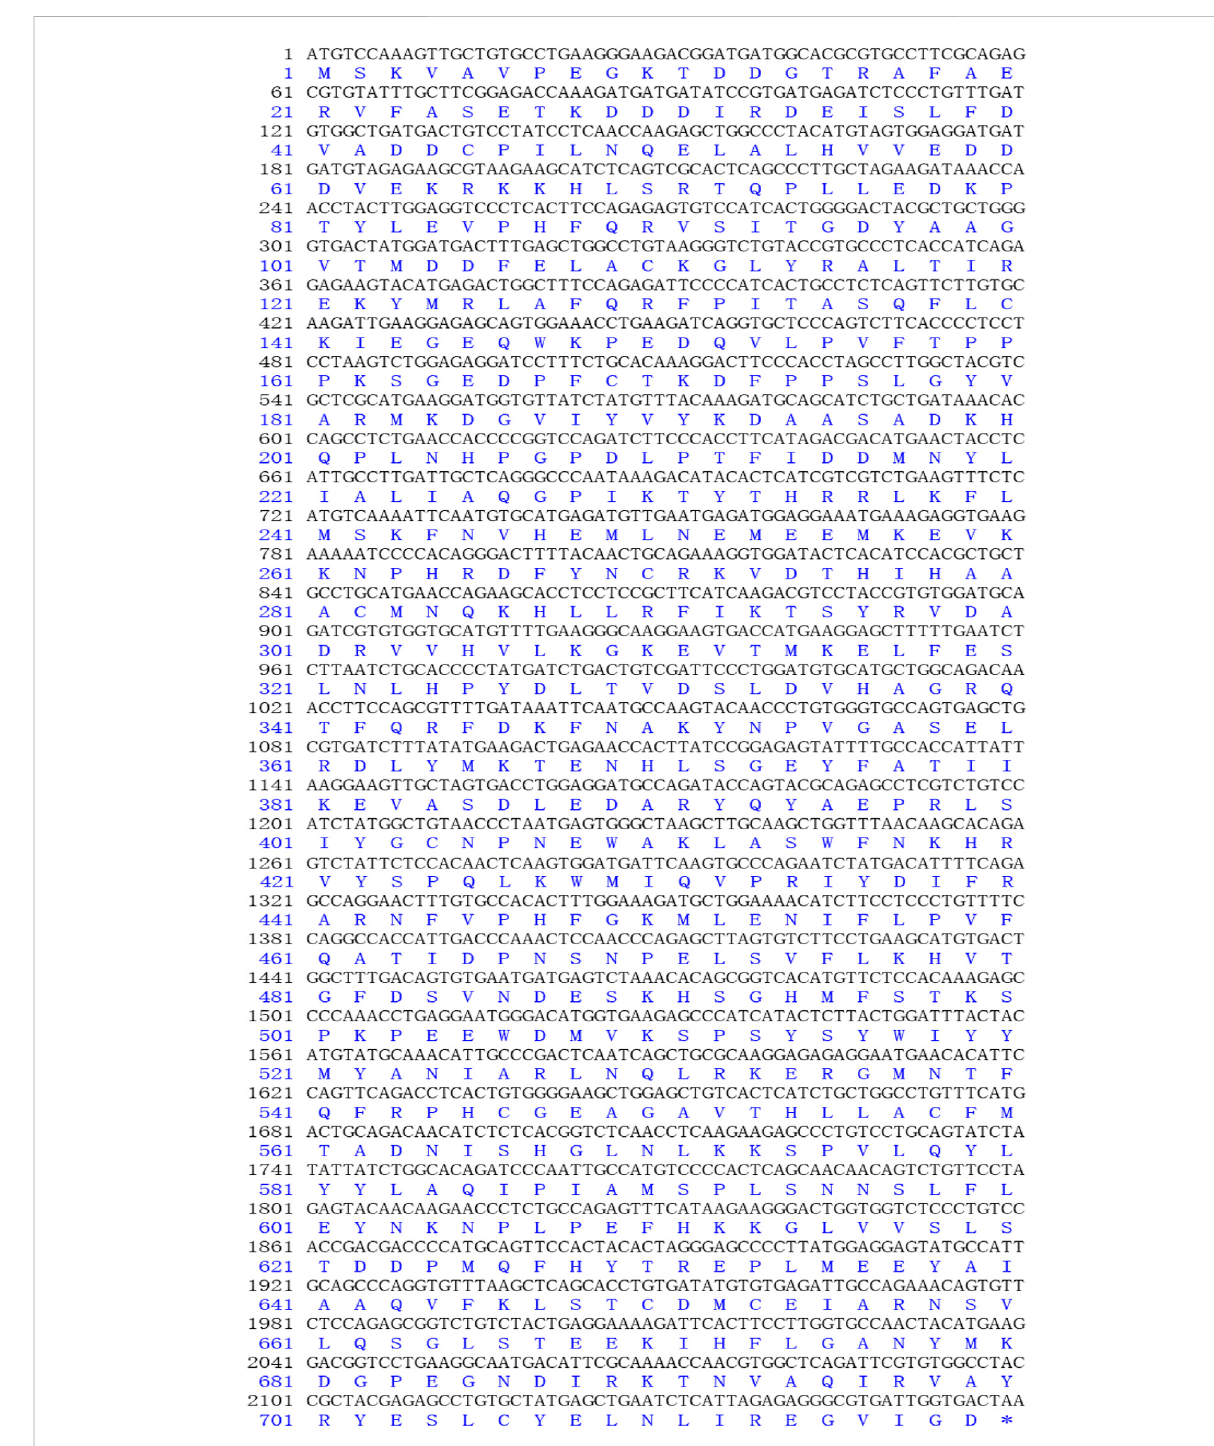
FIGURE 1 The open reading frame (ORF) and amino acid sequences of